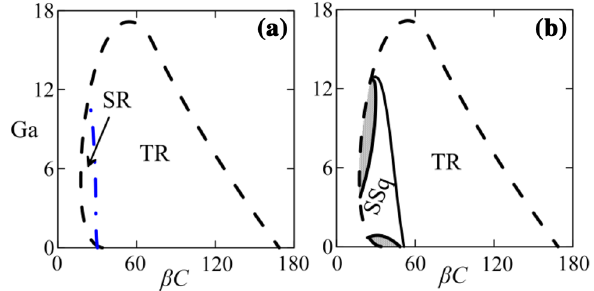
Fig. 5 Selection of oscillatory patterns under quadratic feedback control with 𝜘 q = − 0.2 ( a ) for a pair of counterpropagating waves and ( b ) on a square lattice. Domains of stability for traveling rolls, standing rolls and standing squares are marked by “TR”, “SR” and “SSq,” respectively. The domain of subcriticality is shaded. The dashed line outlines the area, where the oscillatory mode is